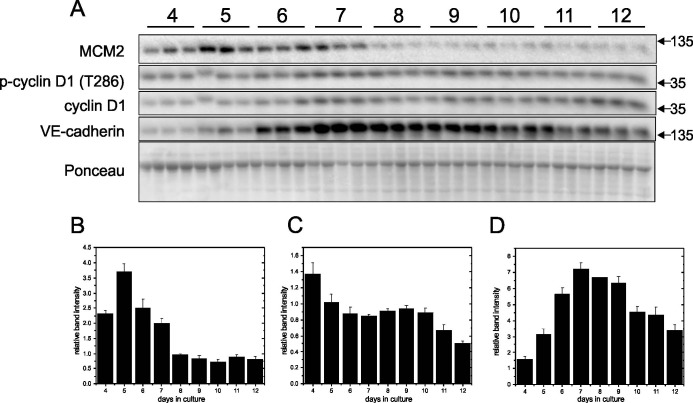
Time course for MCM2, p-cyclinD1, cyclin D1 and VE-cadherin in EA.hy926 cells grown on Matrigel-coated plates.EA.hy926 endothelial cells were seeded on Matrigel-coated plates at 9000 cells/cm2 and grown for 12 days. Protein levels of MCM2, p-cyclinD1, cyclin D1 and VE-cadherin were determined by Western blotting of cell lysates prepared each day from day 4 to day 12. Representative blots are shown in Panel A. Densitometry was used to quantify the intensity of the bands in the upper panel and data were normalized to a band visualized by Ponceau staining. Data are presented as means ± SEM (n = 3) for MCM2 (Panel B), p-cyclin D1/cyclin D1 (Panel C) and VE-cadherin (Panel D).